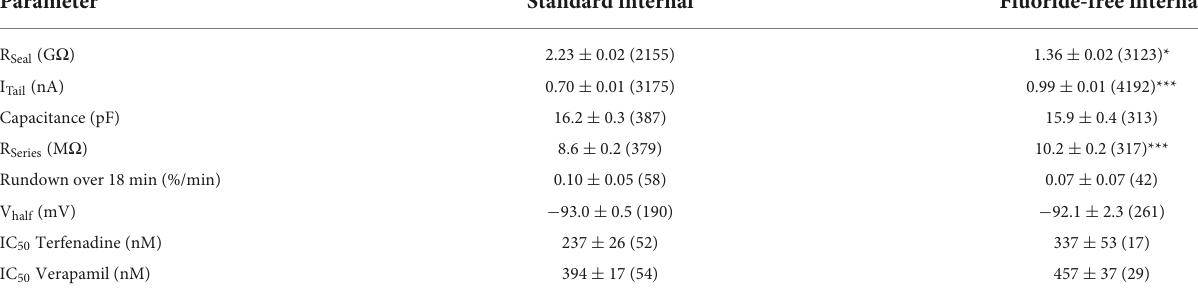
TABLE 2 Parameters for R Seal , I Tail , cell capacitance, R Series , Rundown, V half , and IC 50 values for HEK cells expressing hERG for standard internal and fluoride-free internal solution. Parameter Standard internal Fluoride-free internal R Seal (G (cid:127) )